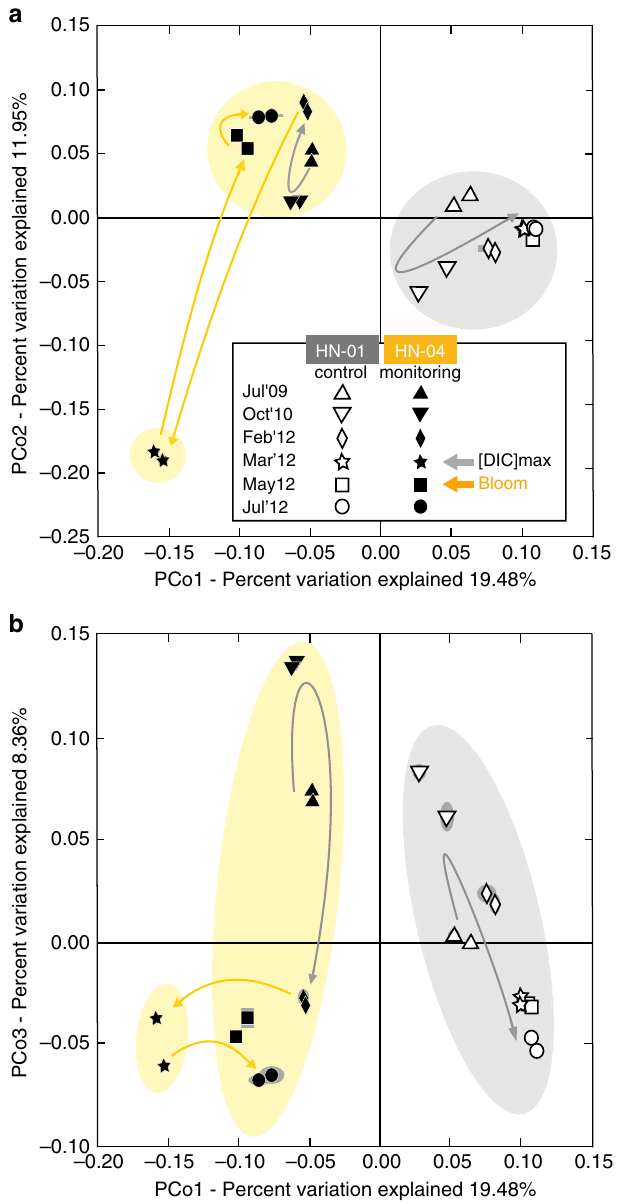
Fig. 4 Principal coordinates analysis of the relative abundance of the 16S- rRNA genes retrieved by 454-pyrosequencing. It re fl ects injection-induced shifts in the composition of the groundwater bacterial community of monitoring well HN-04 ( fi lled symbols), compared to control well HN-01 (hollow symbols). The percentage of variations explained by the fi rst three principal coordinates is indicated on the axes (in a and b for PCo1/PCo2 and PCo1/PCo3, respectively). Lines and halos on symbols represent numerical uncertainties (1,000 replicates). Arrows illustrate evolution through time. A continuous trend characterizes the HN-01 bacterial community, likely re fl ecting natural variations of the aquifer chemistry 11 (Supplementary Table 2). Chemical variability is naturally induced by regional groundwater fl ow along with magmatic degassing from the Hengill volcanic system. Although the drift is also visible in well HN-04 groundwater, its evolution is typi fi ed by a disruptive and rapid shift upon acidifying CO 2 injection, which drastically impacted the community